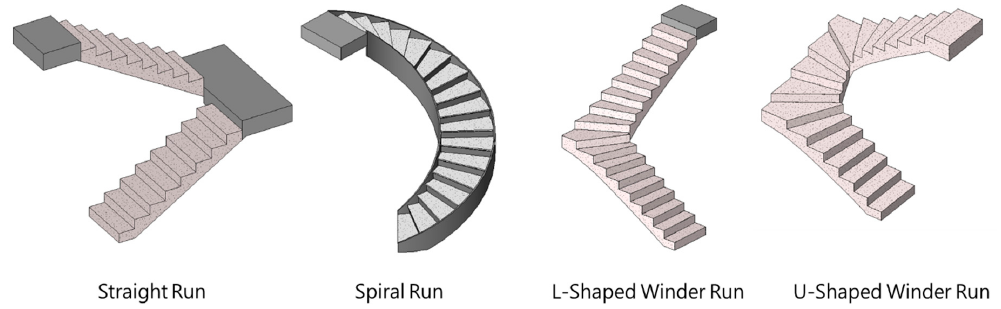
Figure 1. Categories of common stair runs.